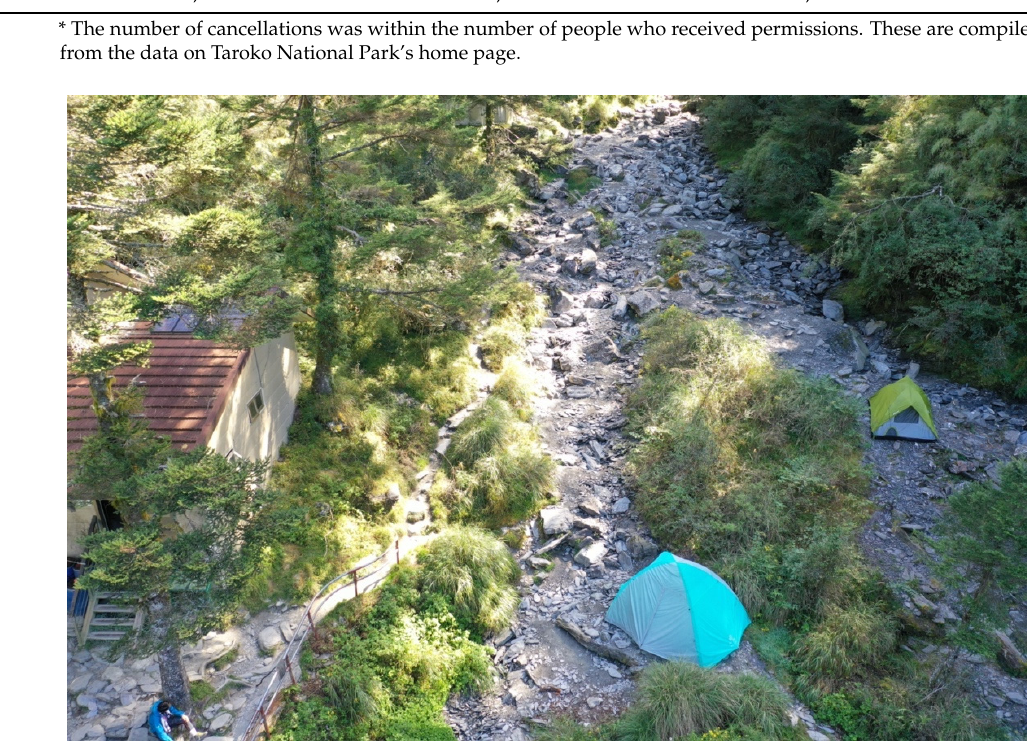
Figure 10. Tents pitched on the riverbank next to the Chenggong cabin ( left ) in Taroko National Park (This photo was captured by drone on 13 October 2019). (This photo was captured by drone on 13 October